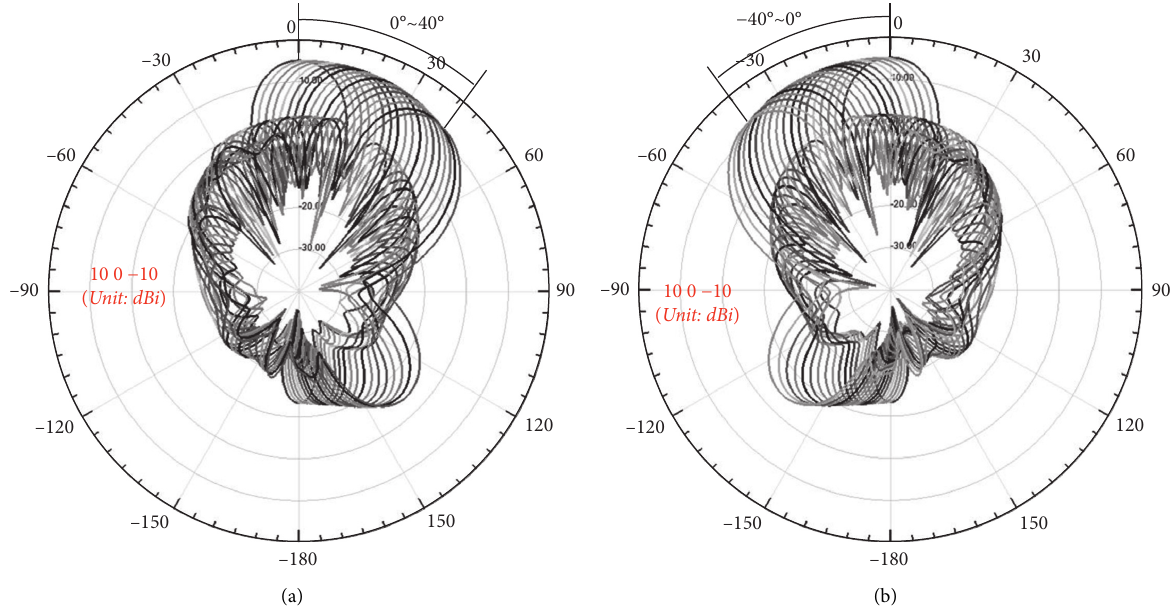
Figure 12: Proposed 34 elements thinned array antenna beam scanning angle range of 0 ° ∼ 40 ° (a) and − 40 ° ∼ 0 °